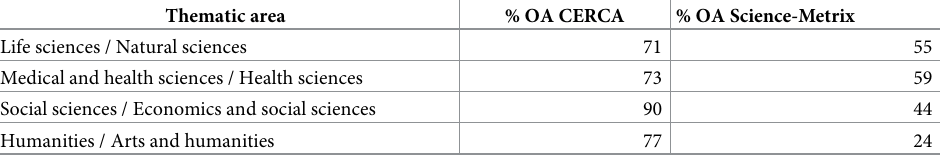
Table 6. Comparison of the percentages of open access for CERCA and Science-Metrix according to thematic area.